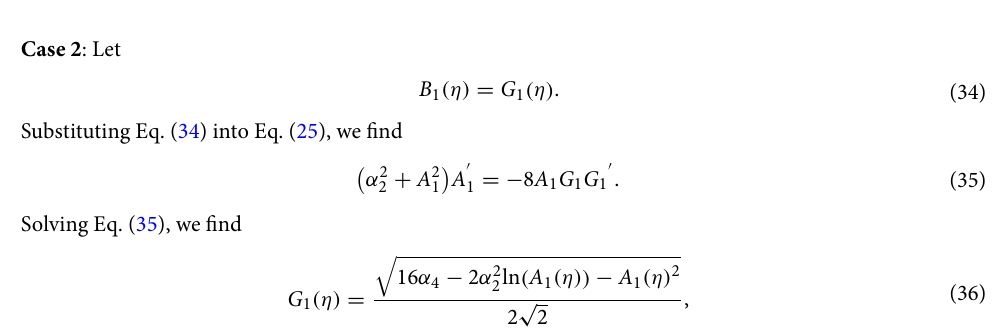
Figure 6. Plot of the solutions (39) and (40) when A 1 different values of α